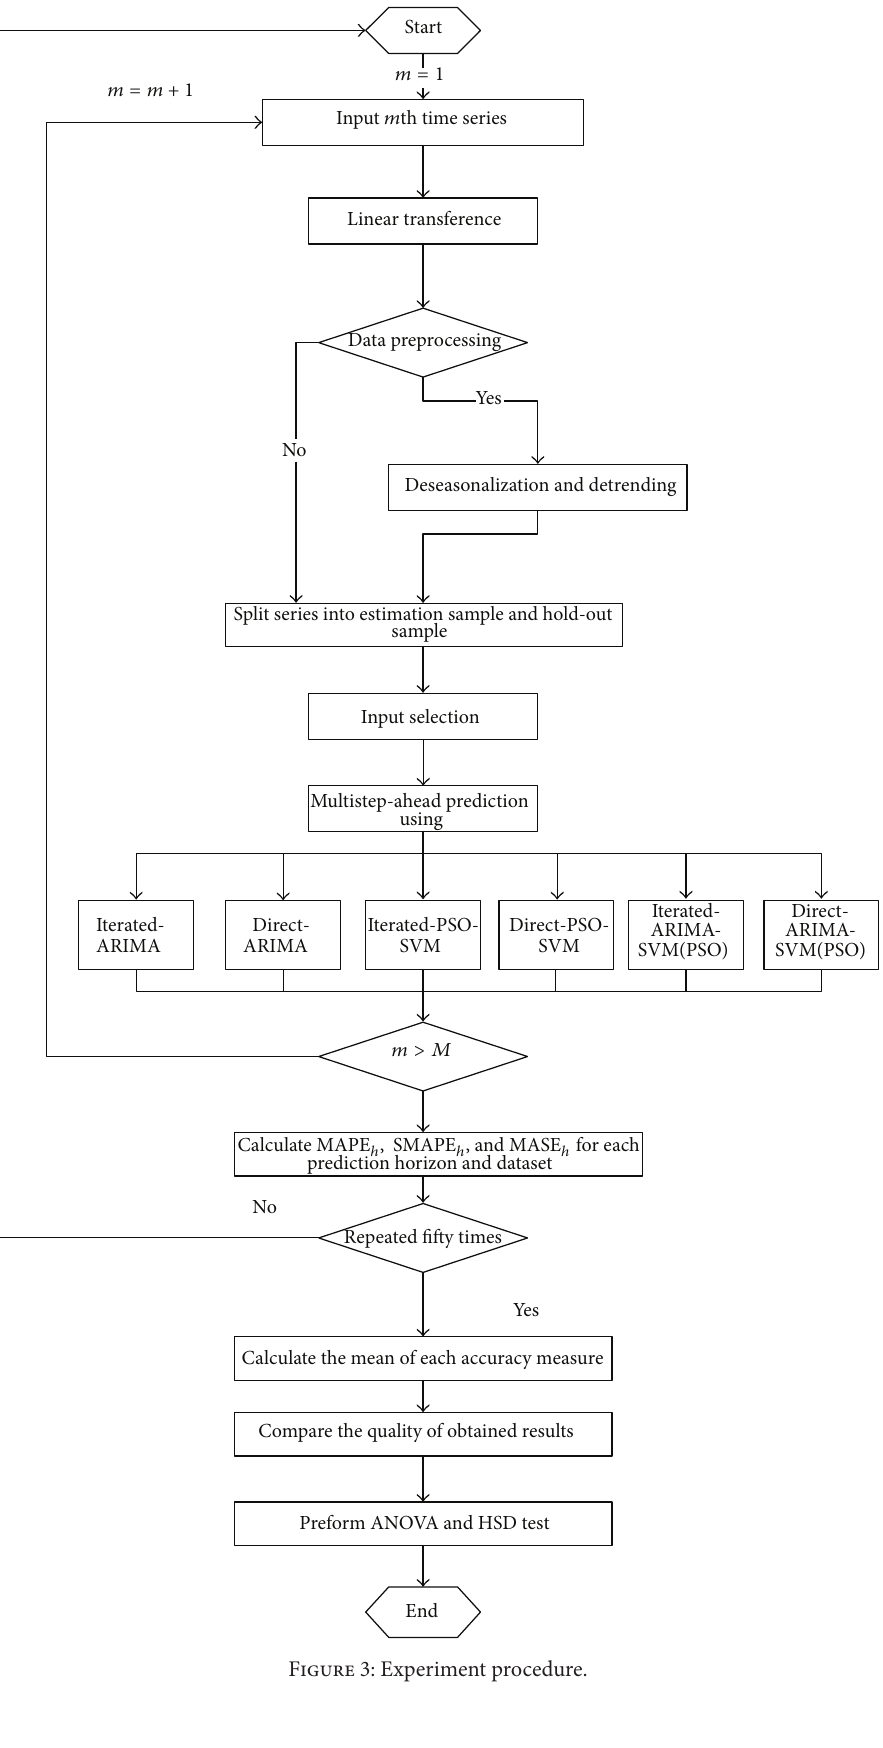
Figure 3: Experiment